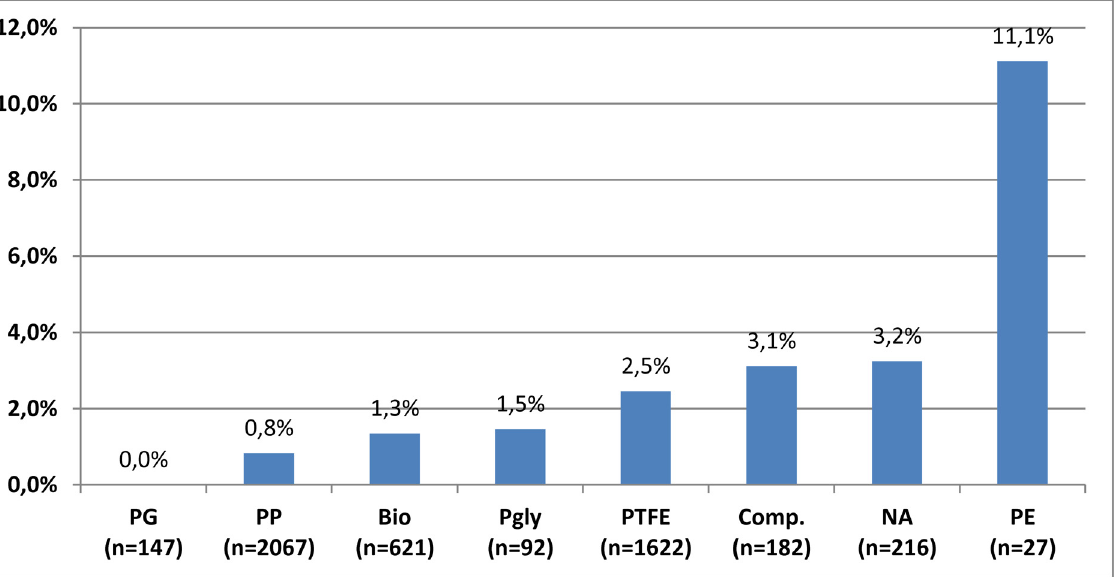
Fig 6. Mesh material-related risk of mesh associated complications. Comp., Composite; DM, dermal matrix; PE, polyethylene; PG, polyglactine; PGly; polyglycane; PP, polypropylene; PTFE, polytetrafluorethylene; SIS, small intestinal submucosa; NA, not